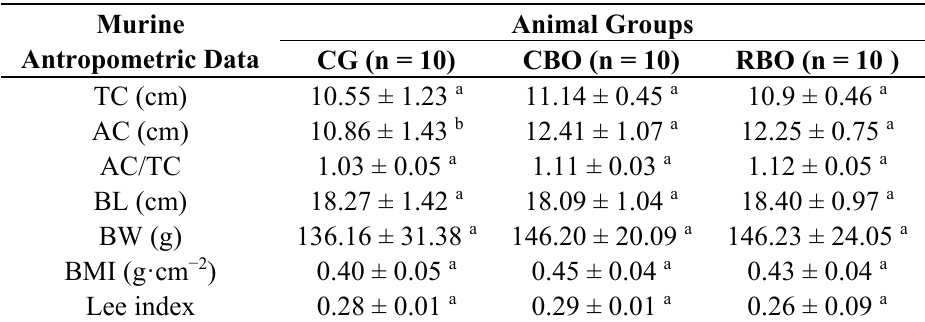
Table 2. Murine variables of Wistar rats fed with diets added of soybean oil or refined or crude buriti